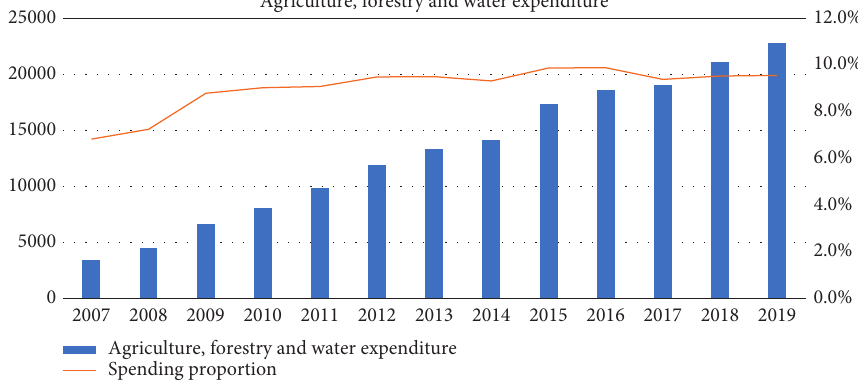
Figure 4: Trends of expenditure on agriculture, forestry, and water in China from 2007 to 2019.